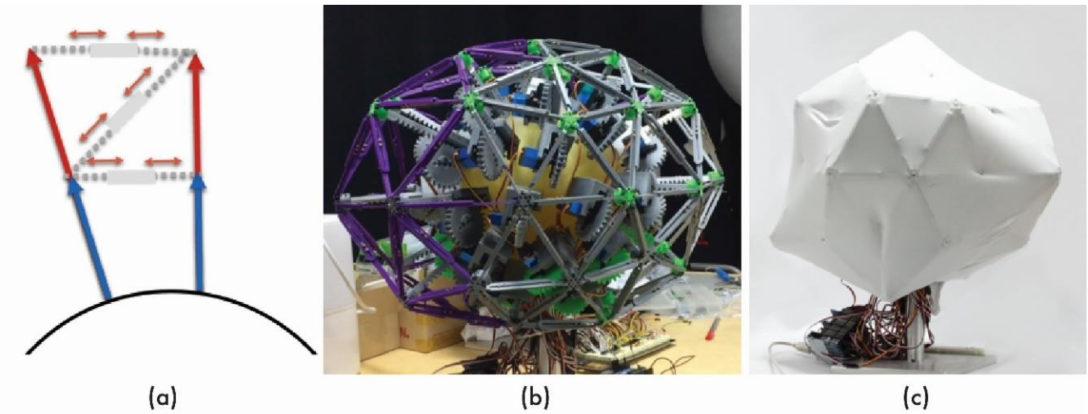
Figure 13. Design with cross-rod that prevents the curvature of the screen by maintaining a straight line between actuating pins: ( a ) concept of driving a cross-rod bridge (gray), ( b ) internal structure with the cross-rod bridge, and ( c ) with Lycra